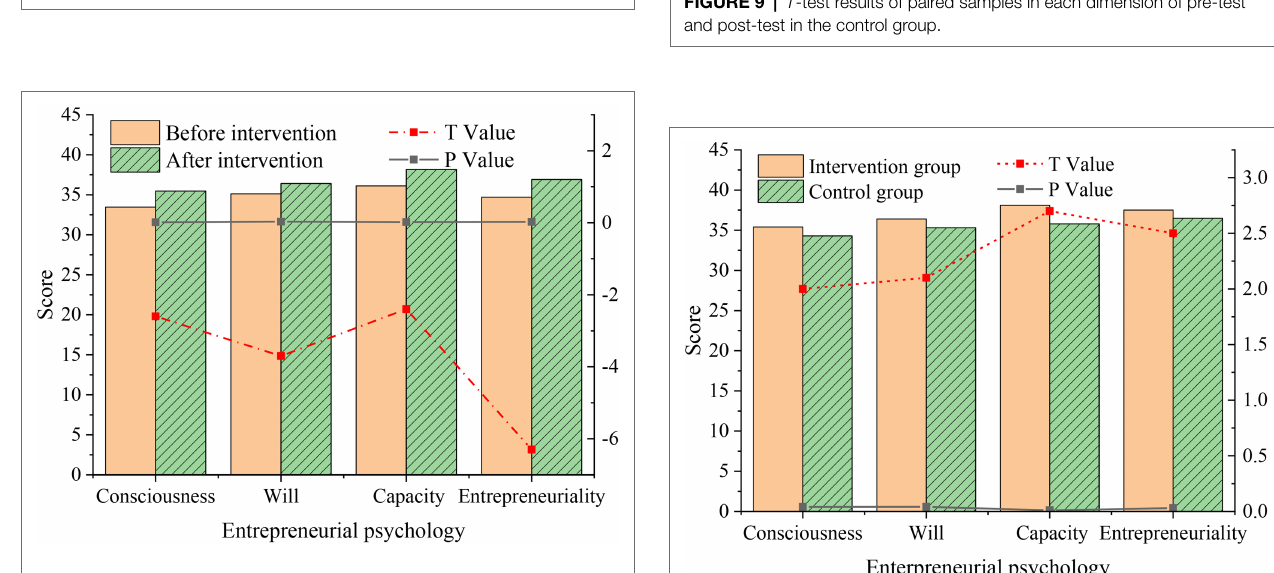
FIGURE 8 | Statistics on the difference of entrepreneurial level after film appreciation in the intervention group.